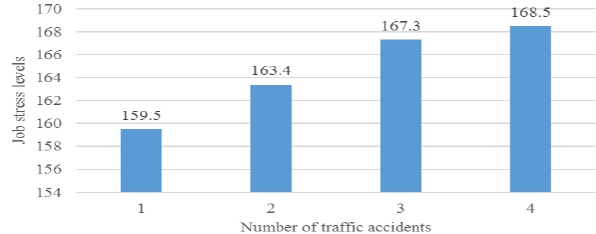
The results of a logistic regression test in a relational study of job stress and noise exposure of drivers, with or without the presence of a traffic accident in 2021, which was recorded, also showed that drivers’ exposure to equiv- alent levels of noise and job stress increased, so did the likelihood of an accident. Figure 5 shows the current state of the relationship between job stress and accidents.